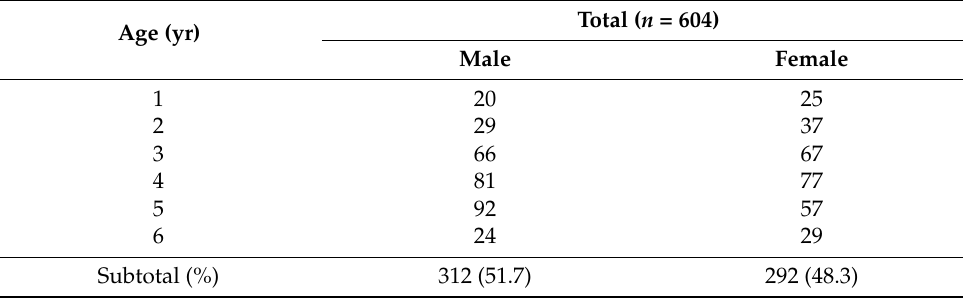
Table 2. Gender distribution of children enrolled in the cross-sectional and vaccine